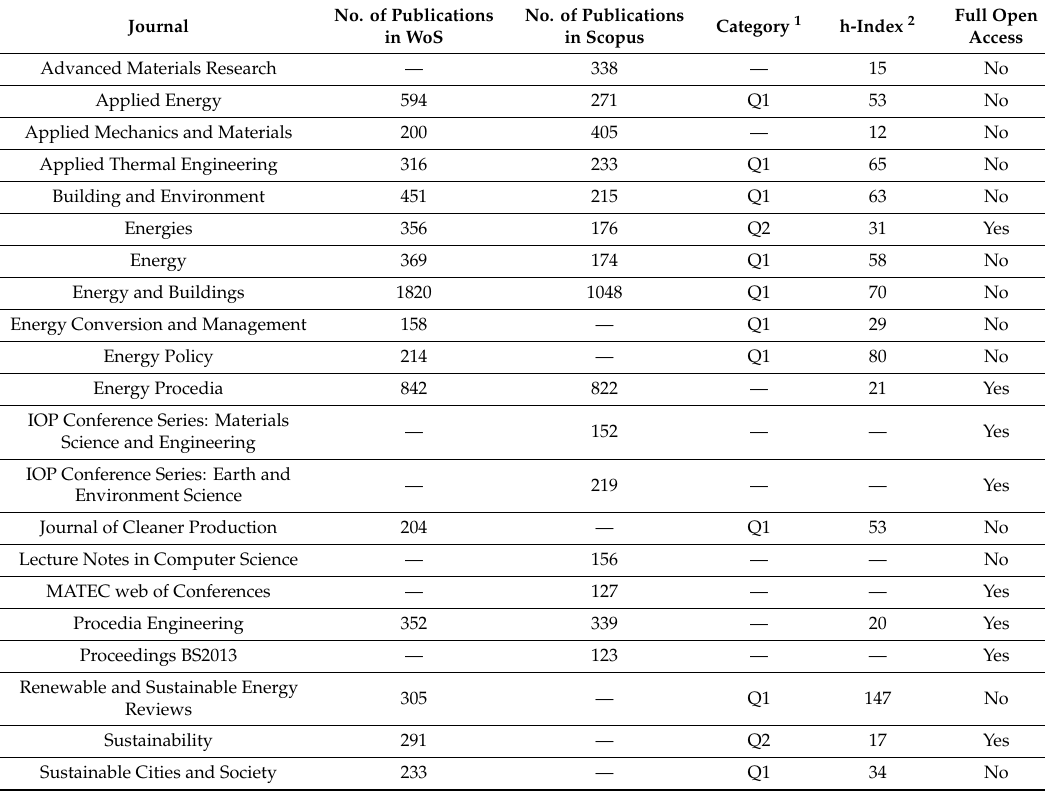
Table 2. Journals where most articles have been published during the period of study, and their impact.